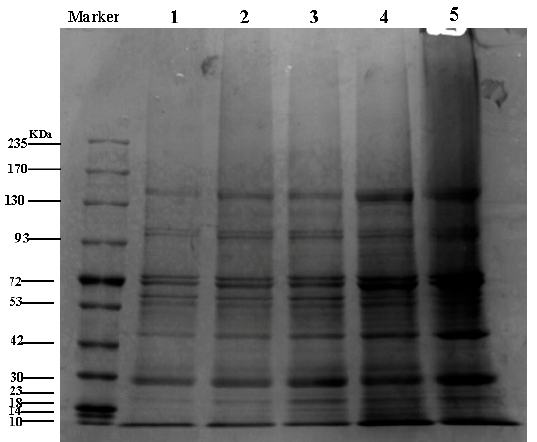
Figure 1. SDS–PAGE of SPI and fractioned products. Marker: the different molecular numbers of proteins: (1) lower protein, (2) upper protein, (3) 11S globulin, (4) 7S globulin, and (5) SPI.